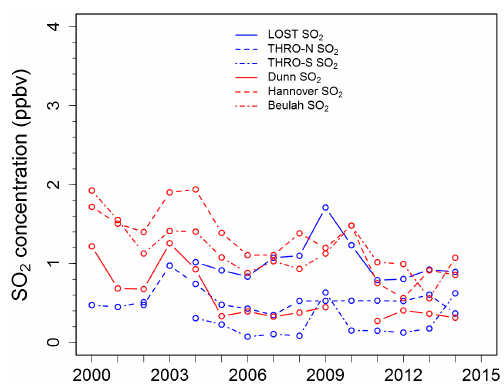
Figure 4. SO 2 monitoring data from the EPA AirData website. Data are annually averaged. Missing data points are for years which had less than 50% of the possible